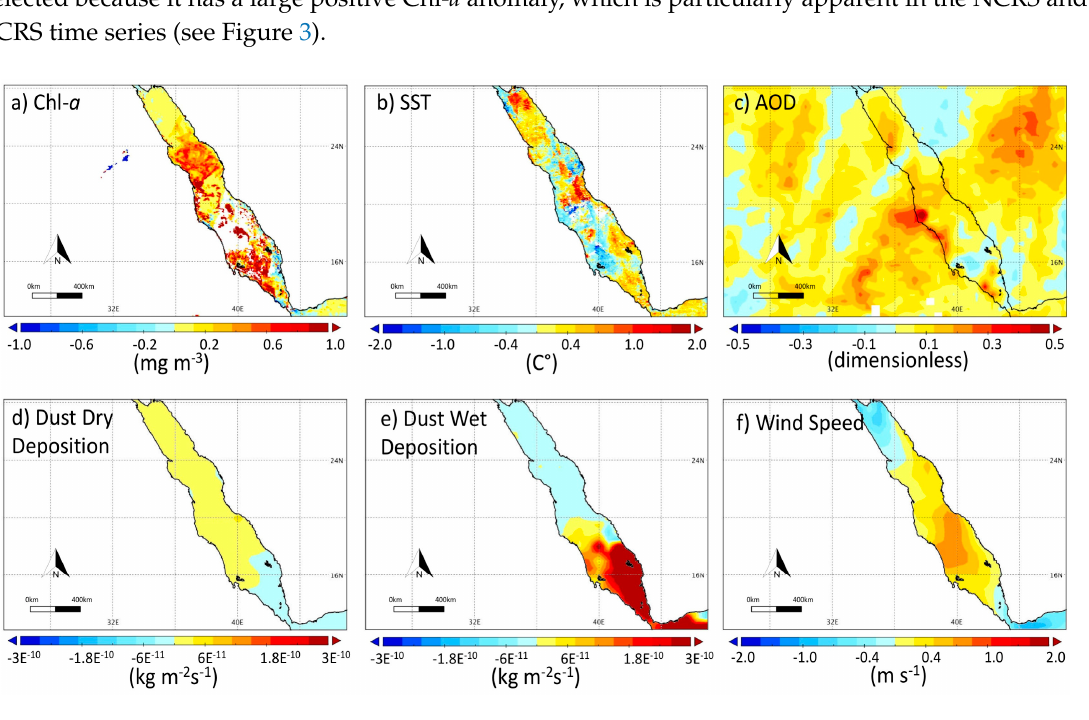
Figure 5. Monthly anomaly maps of ( a ) Chl- a , ( b ) SST, ( c ) AOD (MISR), ( d ) Dust dry deposition, ( e ) Dust wet deposition, and ( f ) Wind Speed for June 2010.